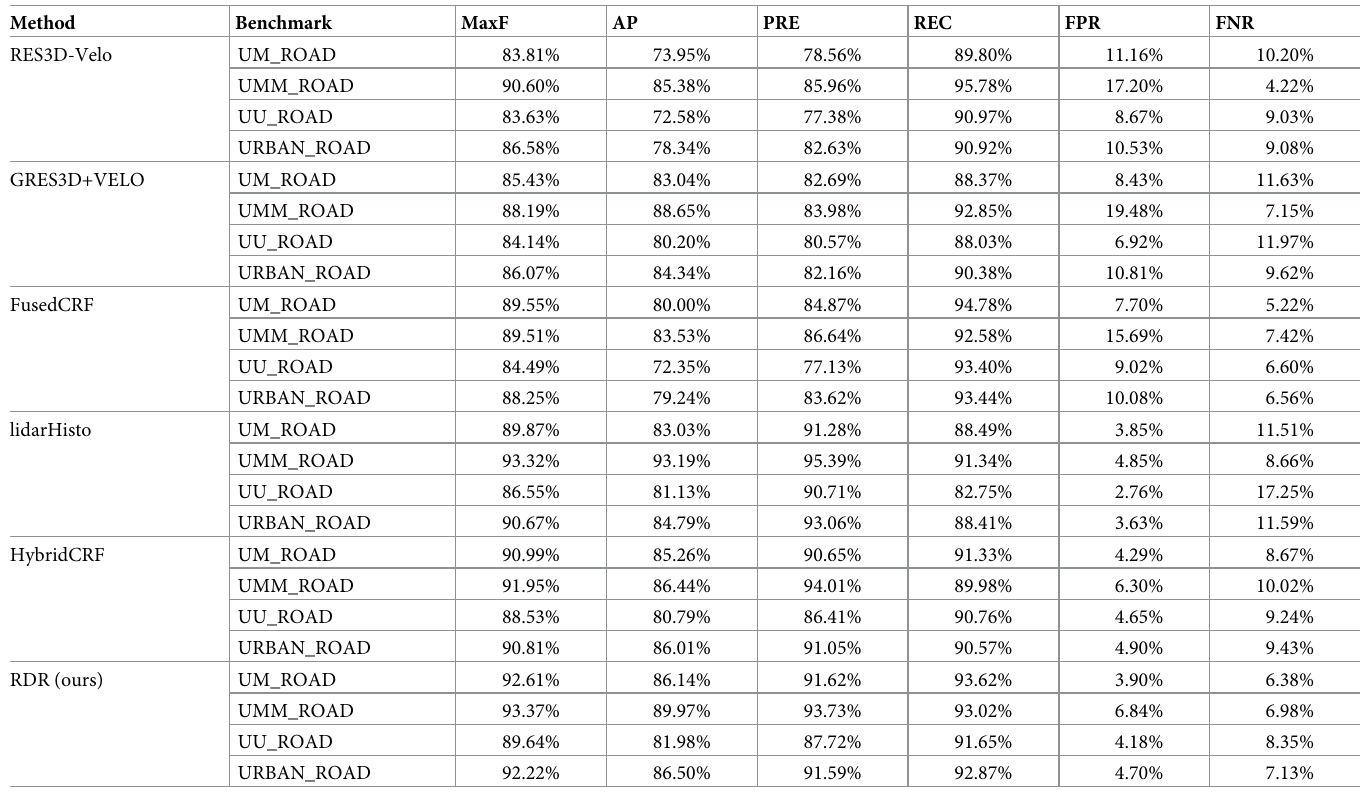
Table 1. Performance comparison with other methods on